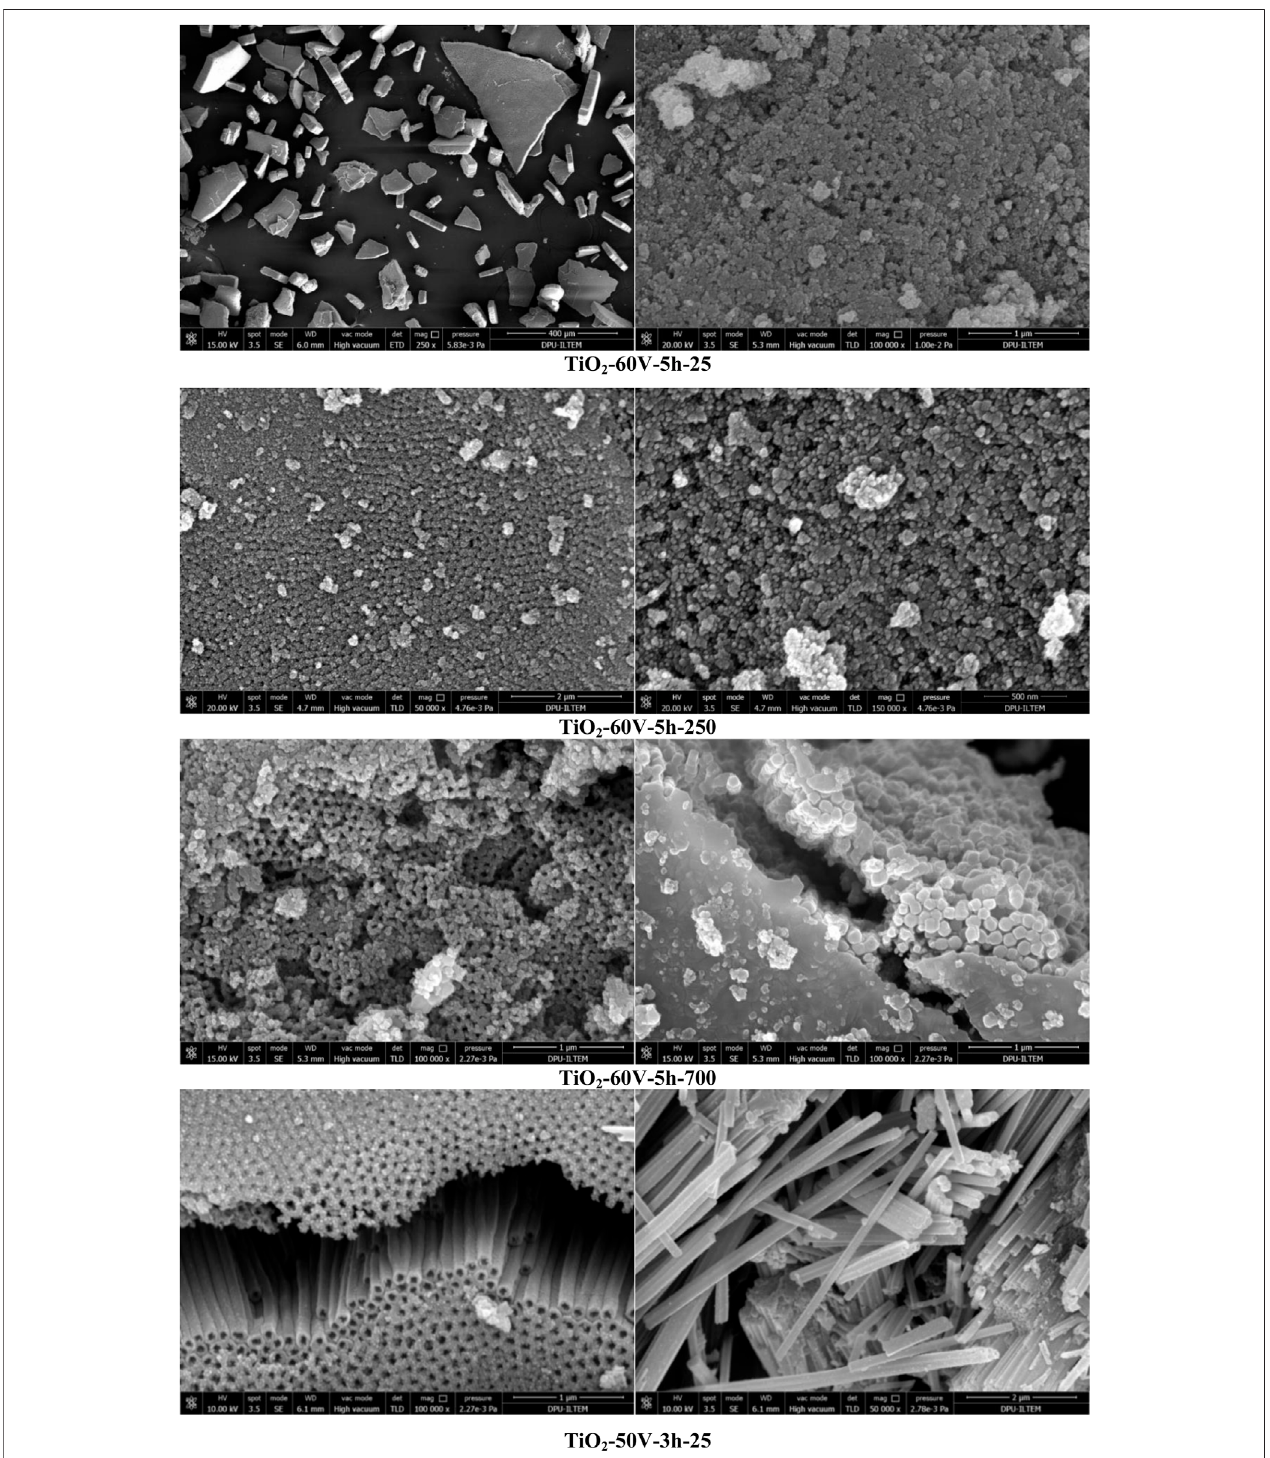
FIGURE 7 | SEM images of the prepared